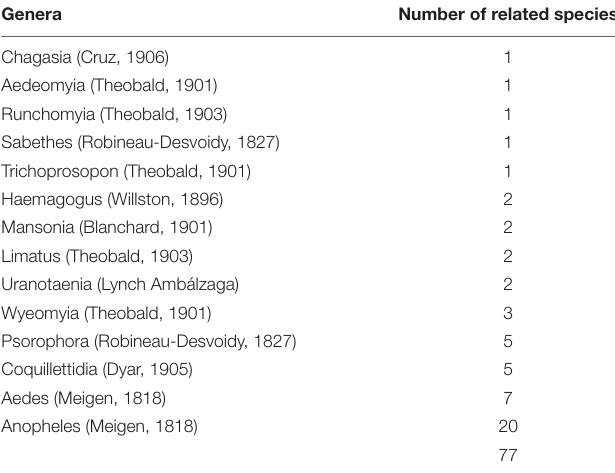
TABLE 3 | List of genera and species stored in